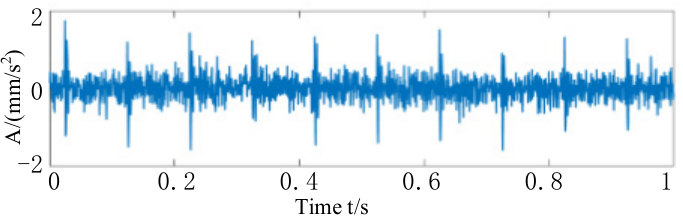
Figure 8. The time-domain waveform of the synthesized signal after the removal of the harmonic components extracted by adapOMP.